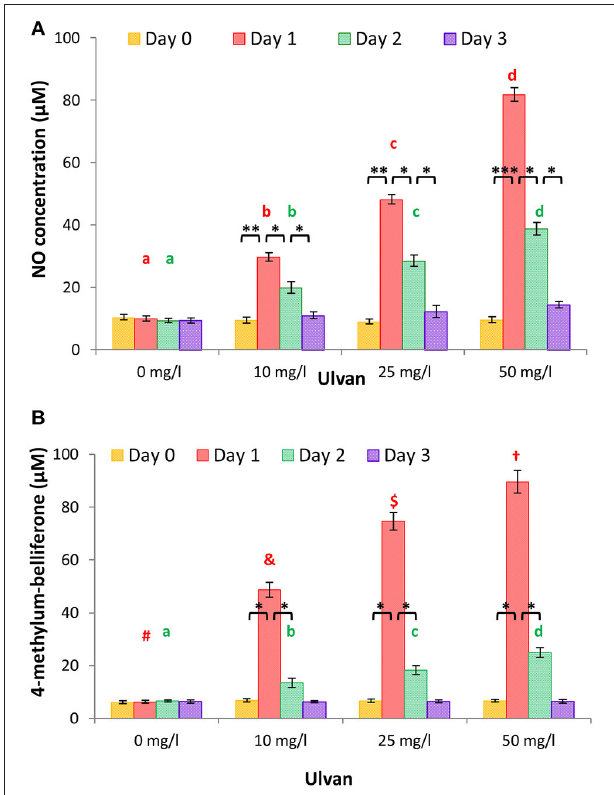
FIGURE 4 | Ulvan acts in vivo when given per os . Ulvan was given per os at four different concentrations (0, 10, 25, 50 mg/l) to the animals at day 0. Blood samples (1ml per animal) were taken every day from day 0 to day 3. The NO concentration and β -D-glucuronidase activity were quantified individually in the plasma, the latter via the 4-methylum-belliferone formation. A dose response release is observed for both NO (A) and β -D-glucuronidase (B) with a peak at day 1. Data represents the mean ± SEM of three independent experiments with 25 chickens per group. Different letters with the same color indicate statistically different values for the different doses at the same time with p < 0.05, different symbols with the same color indicate statistically different values for the different doses at the same time with p < 0.01. * p < 0.05, ** p < 0.01, and *** p < 0.005 when values are statistically different for the same dose at different